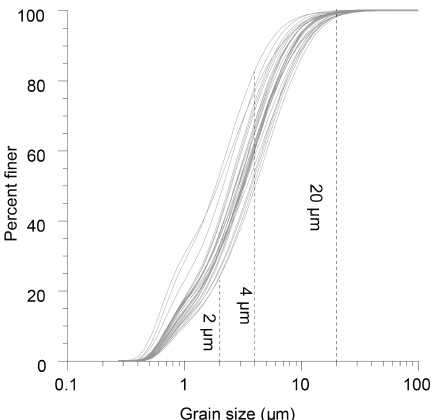
Figure 8. Cumulative grain size distributions for the laminated glacial clays in Asko2018HT-2GC. Sediments are exclusively com- posed of fine fraction material, with 50%–80% of the sediments being <